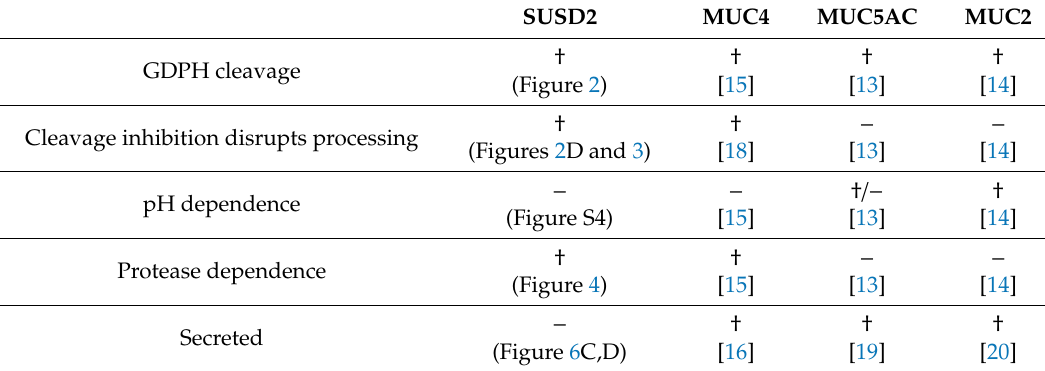
Table 1. SUSD2 and MUC Family protein